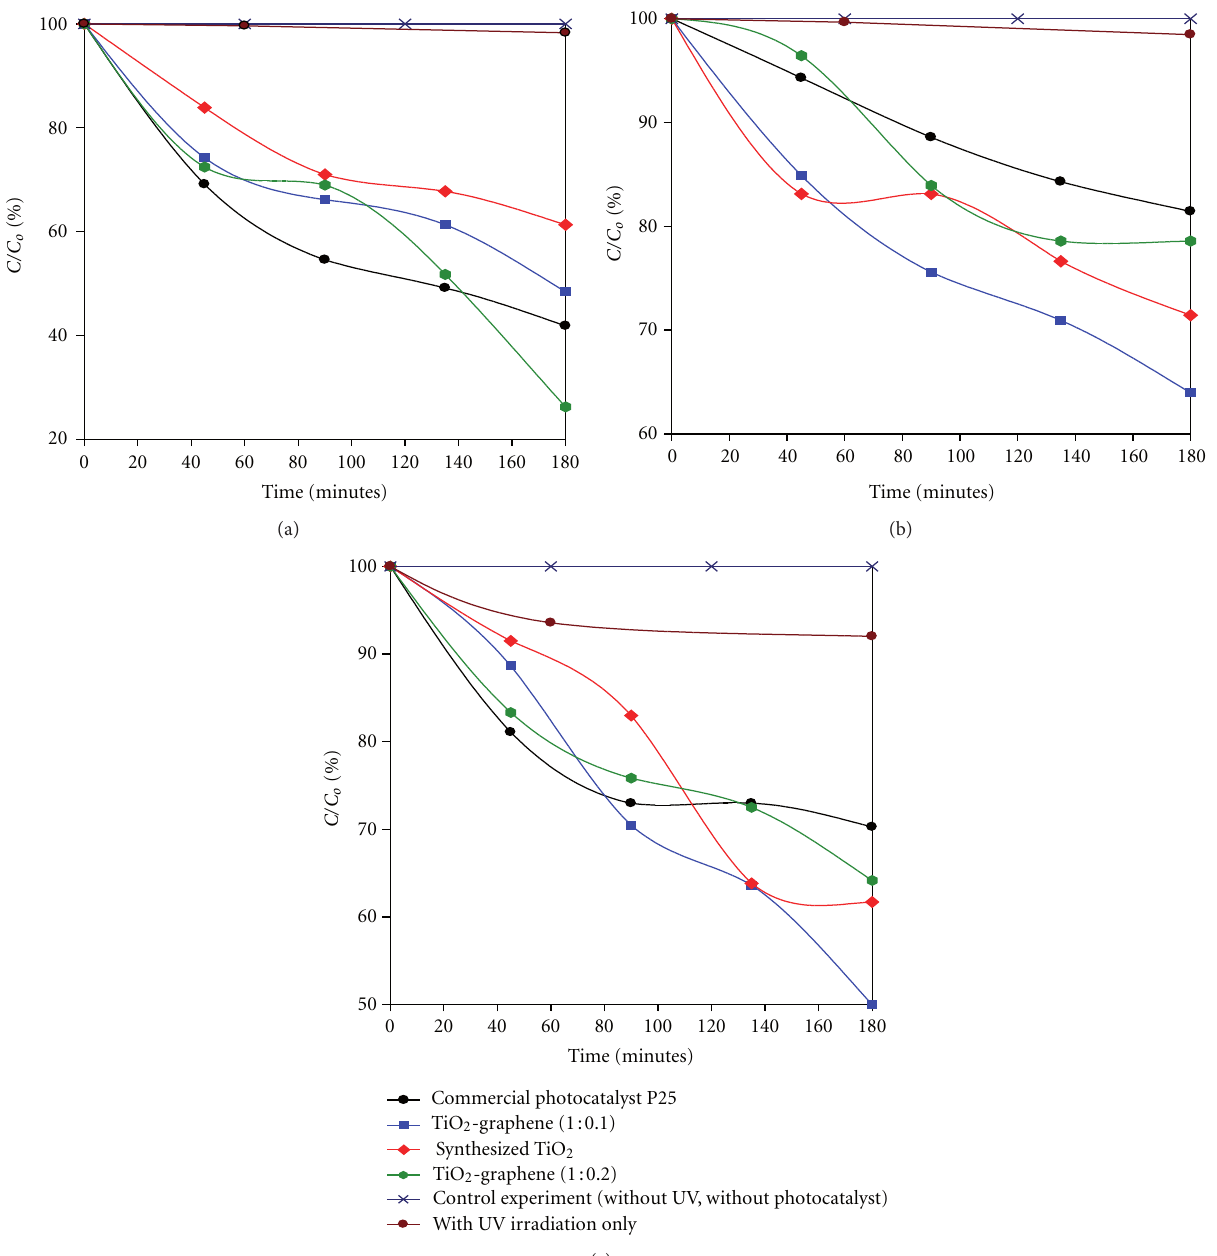
F 7: Photocatalytic degradation pro�les of (a) �-n-heptylphenol, (b) �-nonylphenol, and (c) �-n-octylphenol� percentage of original amount